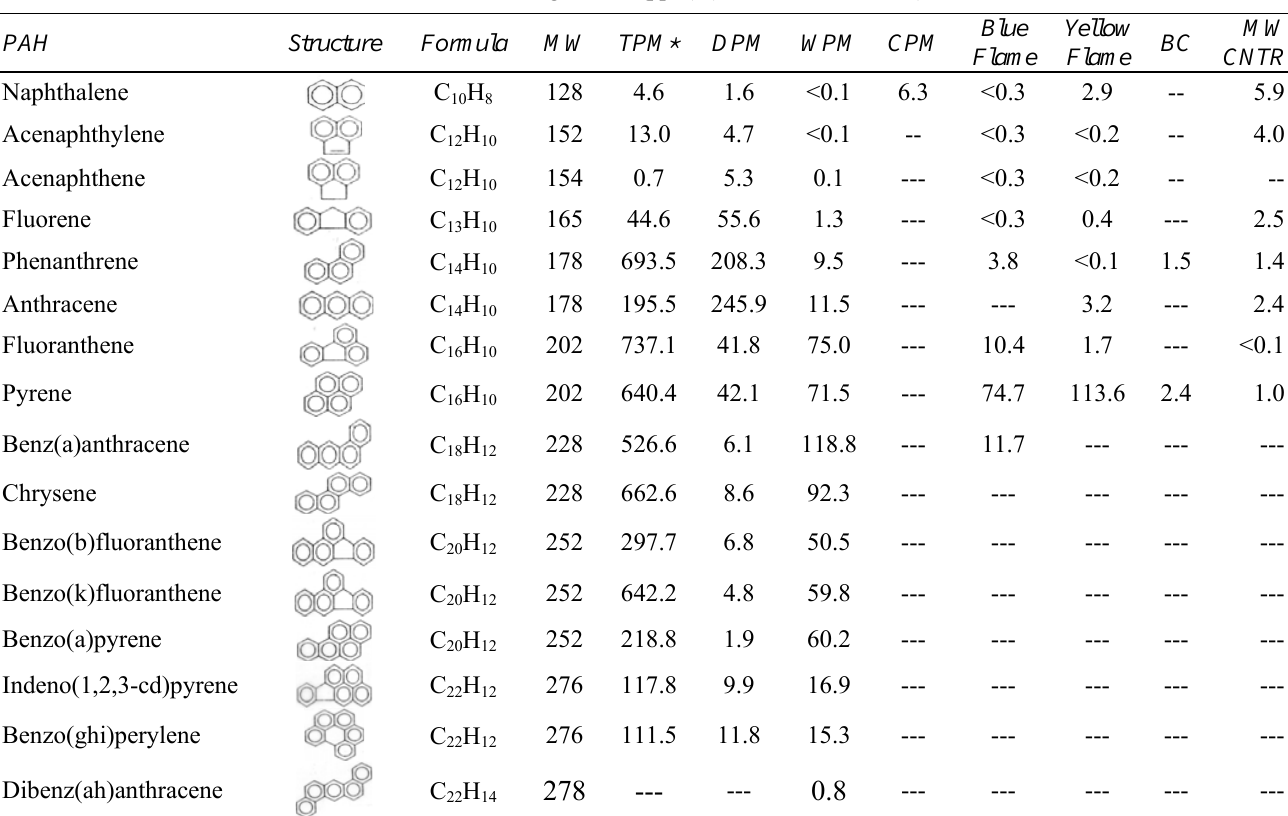
Table 1: PAH content of soot nano-PM and soot surrogate PM (ppm) (From Shi, et al.